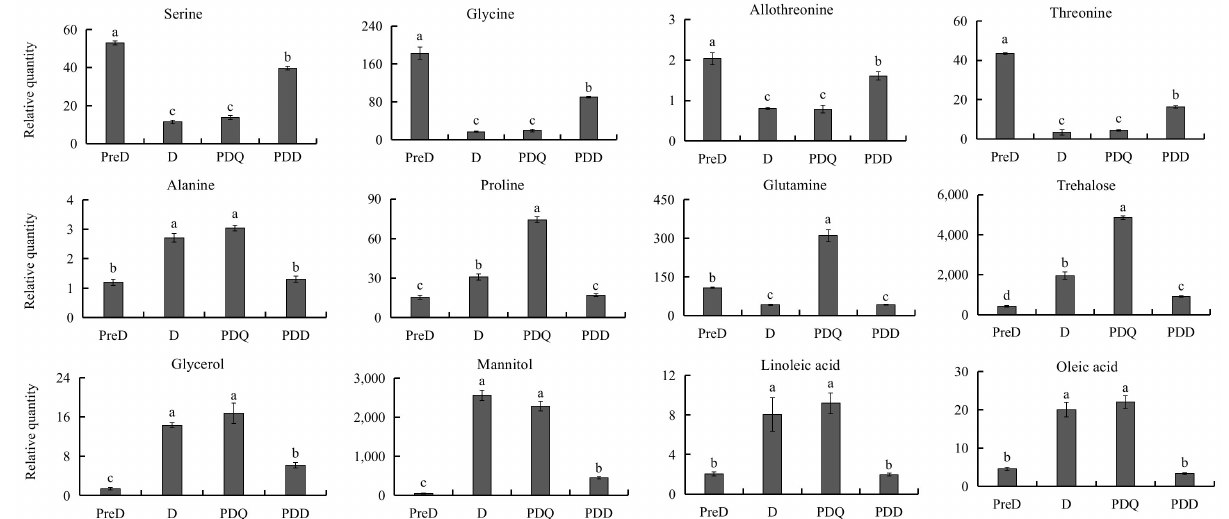
Figure 6. The normalized relative levels of representative metabolites in pre-diapause (PreD), di- apause (D), post-diapause quiescent (PDQ) and post-diapause developmental larvae (PDD) of Sitosiplosis mosellana . Bars represent the means ± SE of six biological replicates and those with different letters were significantly different according to Tukey’s multiple range test ( p <